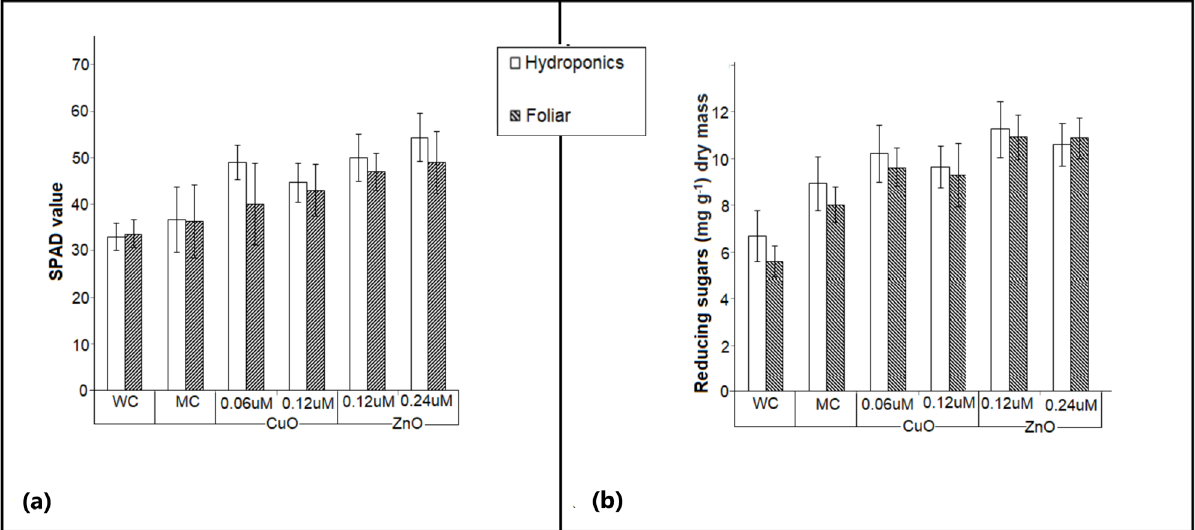
Figure 8. Effect of varying concentrations of biogenic CuO and ZnO nanoparticles applied under hydroponic and foliar setup on biochemical parameters ( a ) SPAD value, ( b ) reducing sugar content in the Amaranthus hybridus plant. A water control (WC) and media control (MC) were maintained.